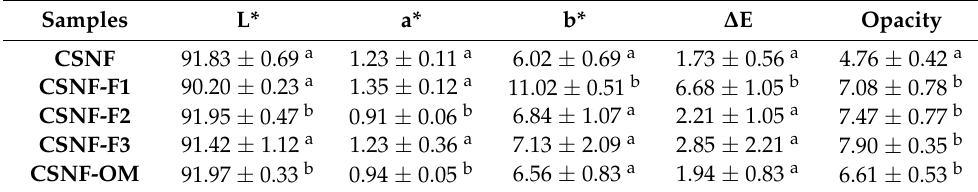
Table 3. Color and opacity of nanocomposite films.